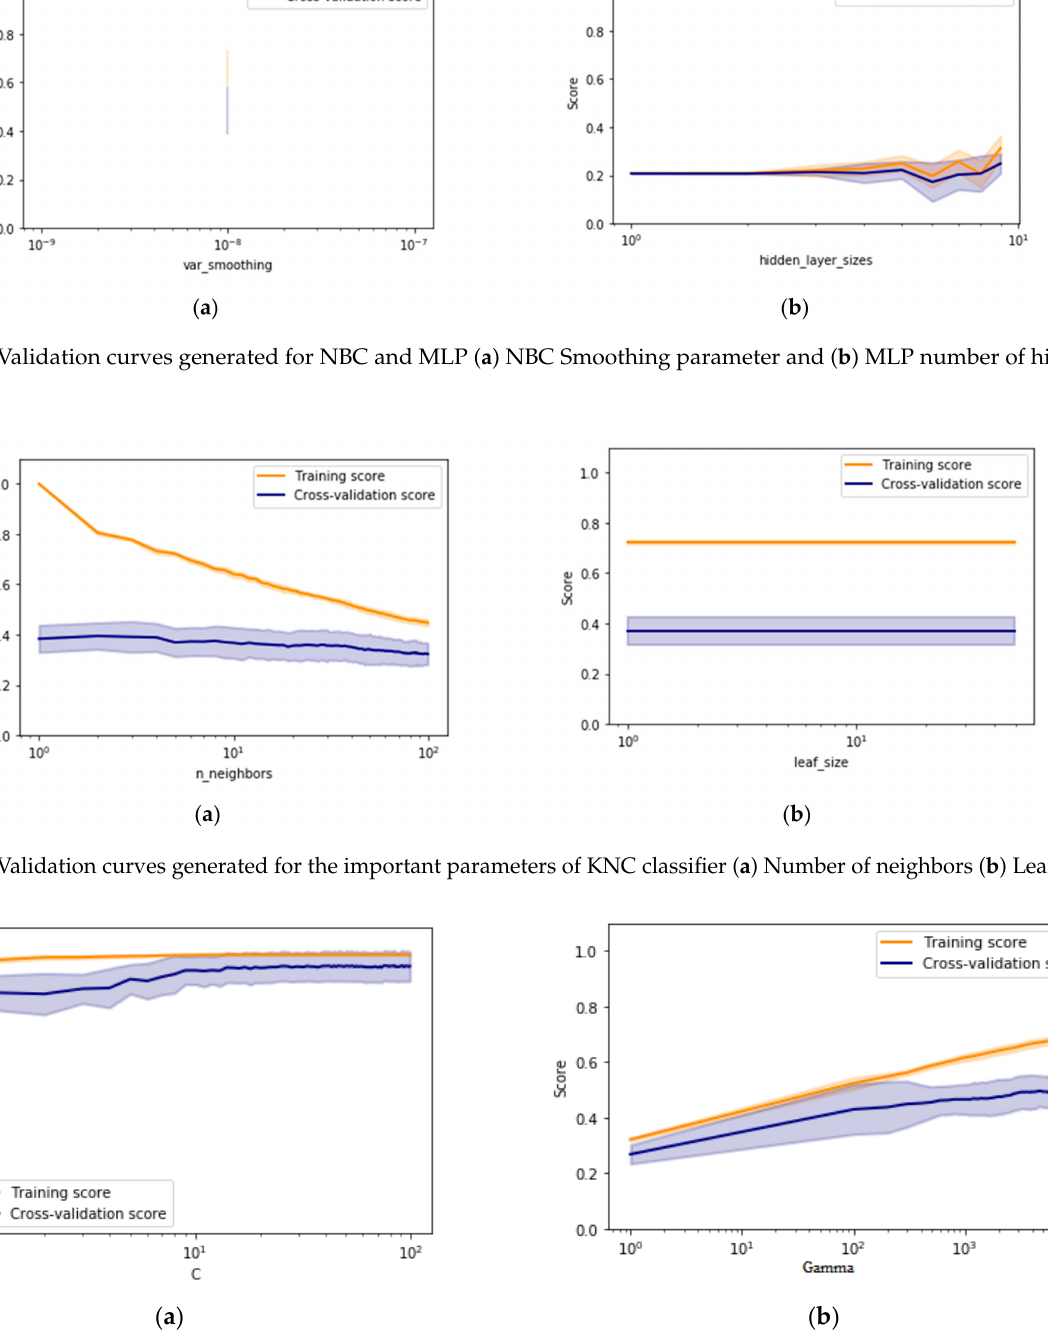
Figure 9. Validation curves generated for two important parameters of SVC classifier ( a ) Regularization parameter C ( b ) Gamma